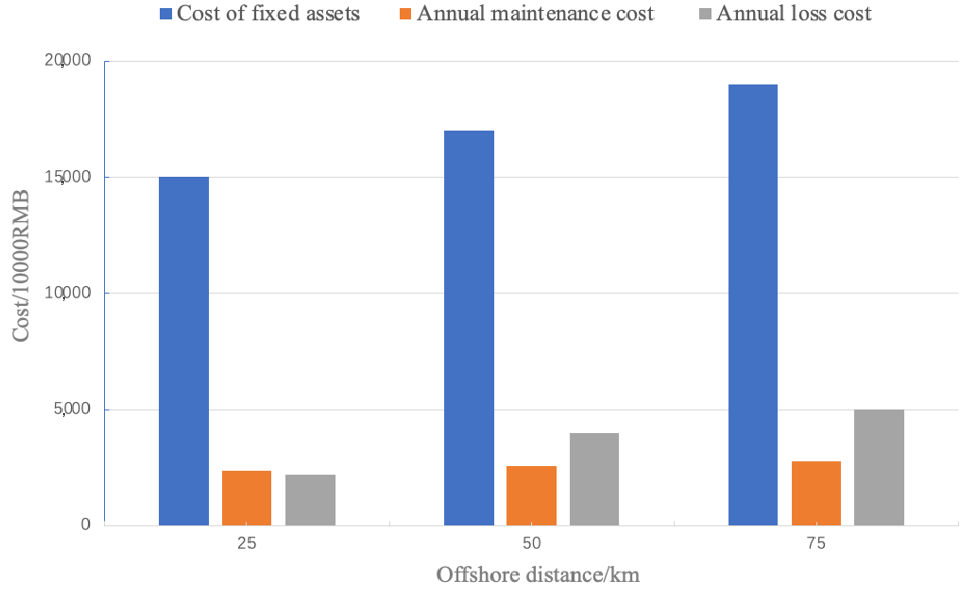
Figure 4. Cost composition of onshore hydrogen production from offshore wind power via AC transmission.